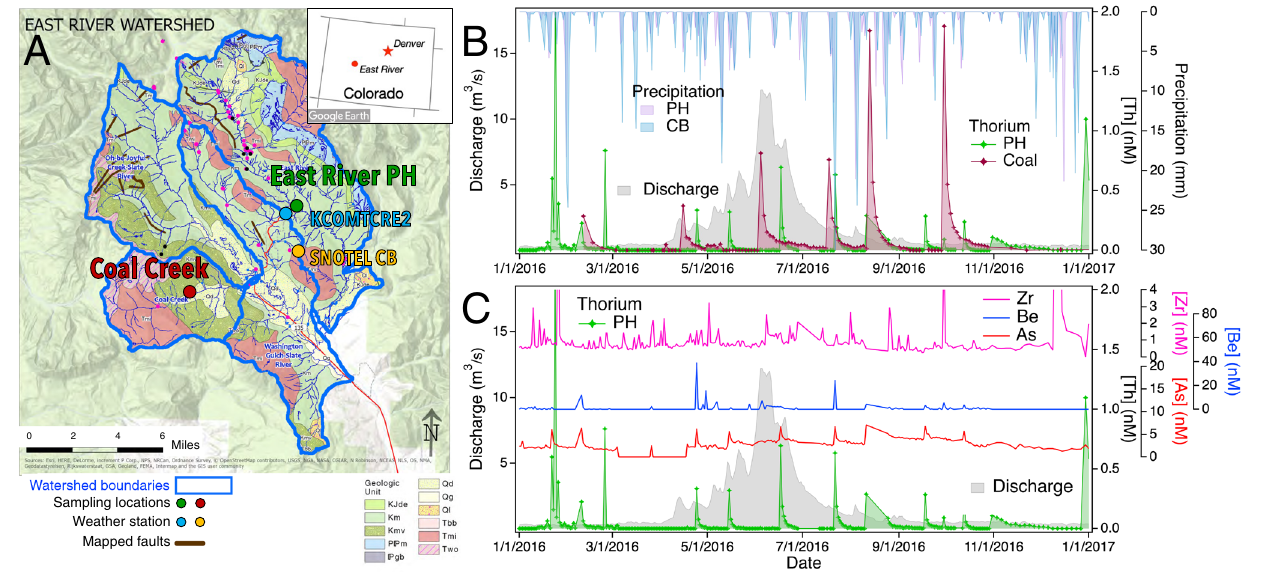
Fig.1|Fieldsiteandmeasurementsofriverwaterchemistry.A Geologicmapof the East River and Coal Creek watershed with locations of principal river water sampling sites (red and green circles), weather stations (blue and yellow circles), and mapped faults (black lines). Map was generated using ArcGIS (Esri, Inc.) with hydrologic data from the National Hydrography Dataset and geologic information from the Gunnison County Geologic Map. See Code Availability Statement for full